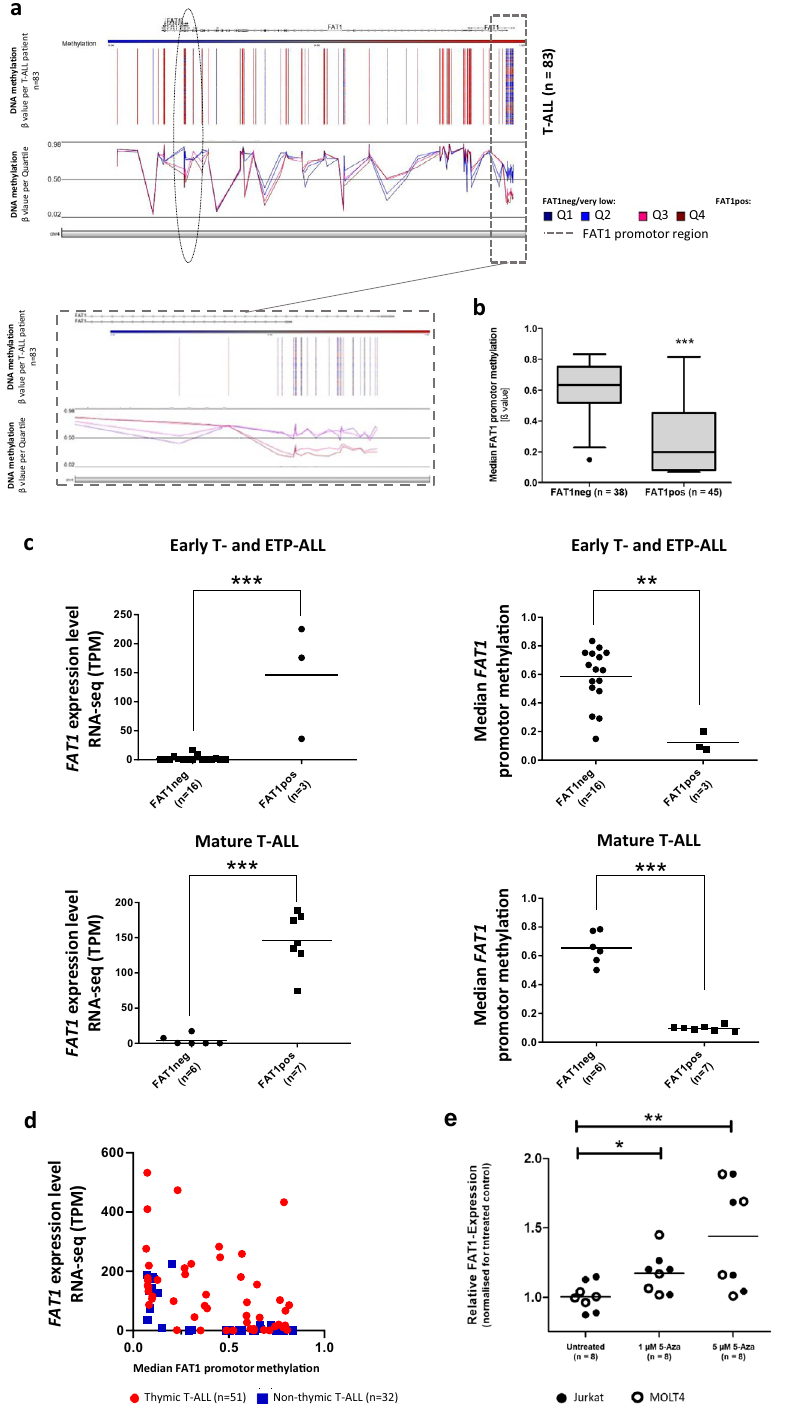
Figure 2. Promotor hypomethylation and FAT1 expression in T-ALL. ( a ) Patient samples were assessed for DNA methylation by HumanMethylation450 BeadChip. β values for DNA methylation for each patient (upper plot) and mean DNA methylation according to expression clusters Q1-Q4 (lower plot) are depicted for chr 4q34-35. Q1/Q2 mainly represent FAT1neg T-ALL patients. The promotor region is marked by the dotted box. ( b ) Tukey boxplot of median promotor methylation comparing FAT1pos (mean methylation score: 0.28; n = 38) and FAT1neg (mean methylation score: 0.61; n = 45) T-ALL samples. Median promotor methylation was significantly higher (p < 0.001) in FAT1neg T-ALL samples. ( c ) Inverse correlation between high FAT1 expression and FAT1 promotor hypomethalation was particularly significant for mature T-ALL compared to ETP/ early T-ALL. ( d ) A correlation plot between FAT1 expression and median promotor methylation with hyperbolic correlation (R 2 = 0.63) is presented in non-thymic T-ALL samples. No such clear correlation could be shown in thymic T-ALL. ( e ) Treatment with demethylating agent 5-Azacytidine (5-Aza) for 24 h in T-ALL cell lines (Jurkat and Molt-4) led to a dose- dependent FAT1 upregulation (*p < 0.05; **p < 0.01; ***p <